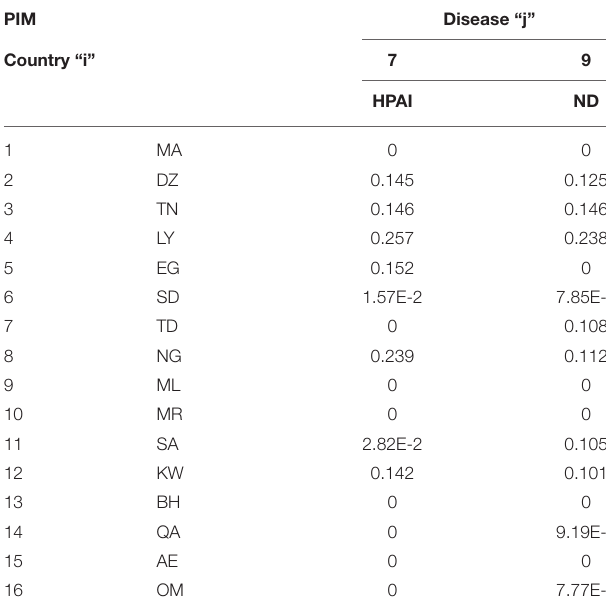
TABLE 8 | Probability of introduction of the j disease into the European Union through wild birds migration from the country i .